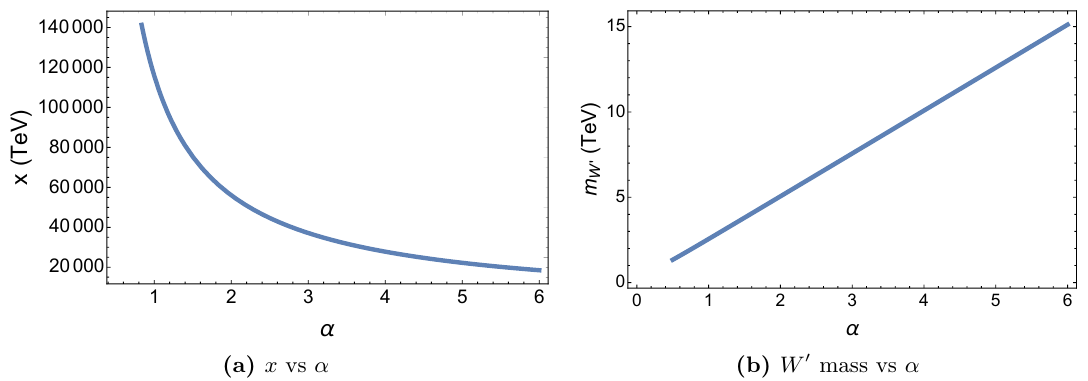
= 4 (left) and m W 0 (right) versus (cid:11) . y 1 = 13 : 8, v 1 = 5, T 1 = (cid:0) 50, 5